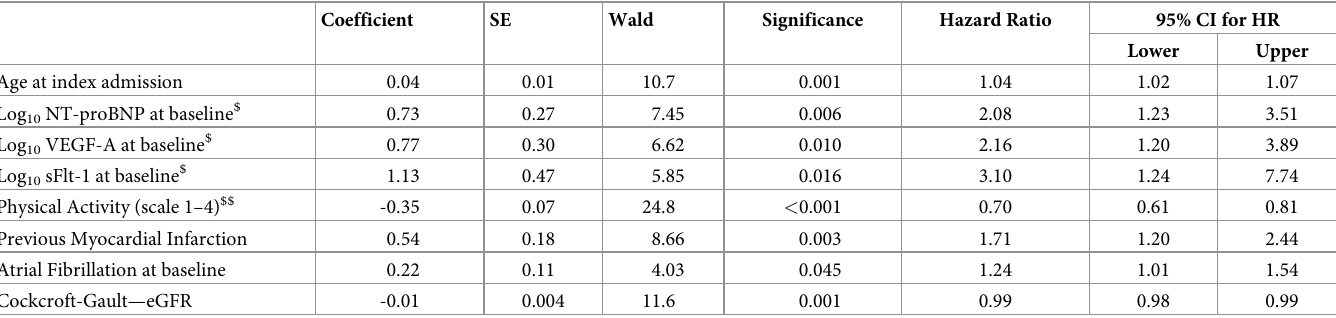
Table 3. Cox’s proportional hazards regression model including baseline VEGF-A and sFlt-1 levels for mortality in the CDCS cohort (n = 458, 139 deaths). Coefficient SE Wald Significance Hazard Ratio 95% CI for HR